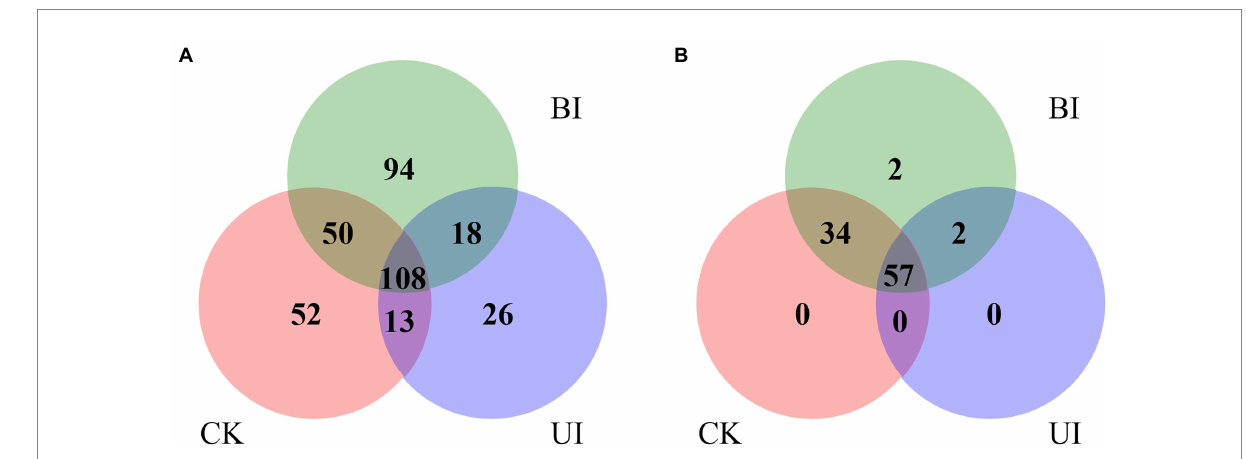
FIGURE 3 Venn diagram indicating the common and unique microRNAs in the control check (CK), the period before infection (BI), and the period under infection (UI) small RNA libraries. (A) Known miRNA distribution and (B) novel miRNA